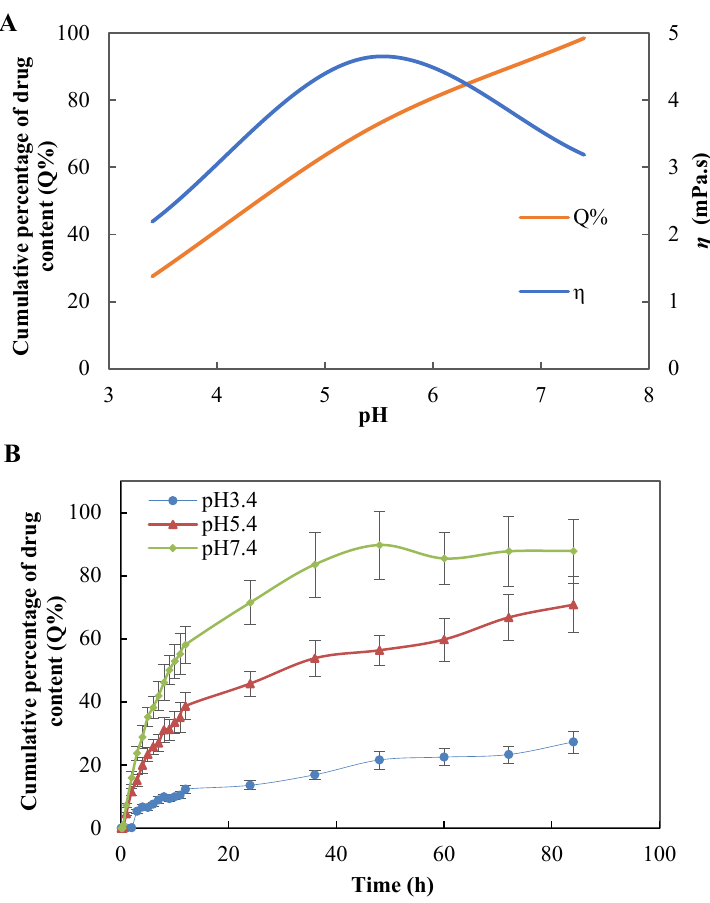
Figure 7. ( A ) Viscosity of hydrogel and final cumulative permeation rate at different pH values. ( B ) In vitro diffusion study of KAE-GEL through dialysis membrane (MW: 8000–14,000) at different pH values at 37 °C.